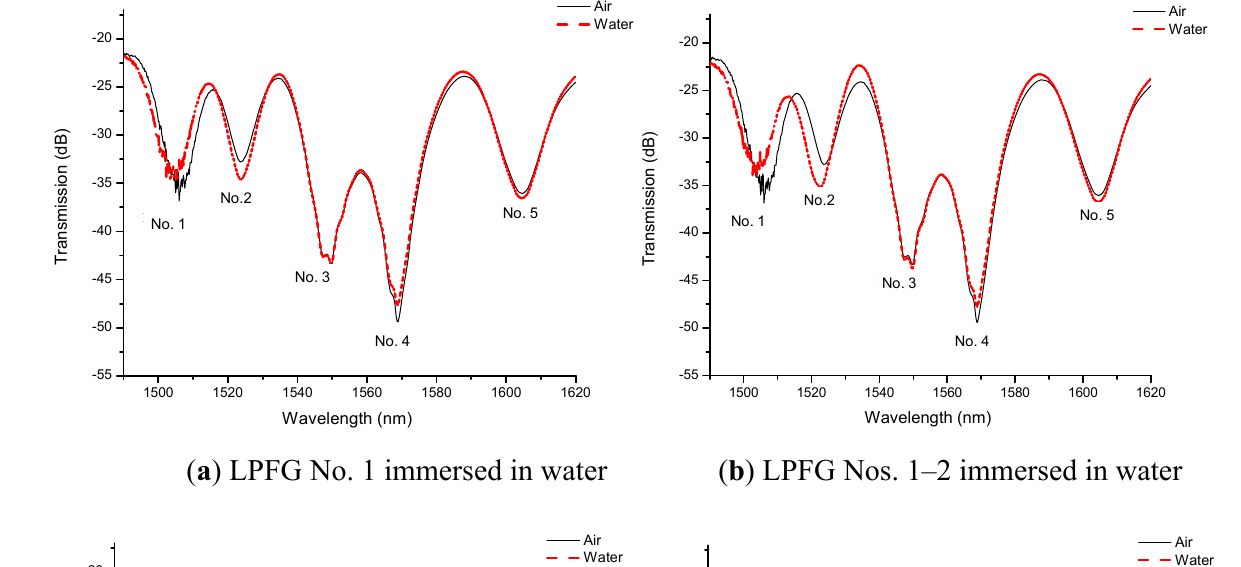
Figure 5. ( a–e ) Transmission spectra of the liquid level sensor with LPFG Nos. 1, 2, 3, 4 , and 5 immersed in water (22, 42, 62, 82, and 102 cm liquid levels), respectively; ( f ) Box plot of average wavelength shifts by performing five times reflective liquid level